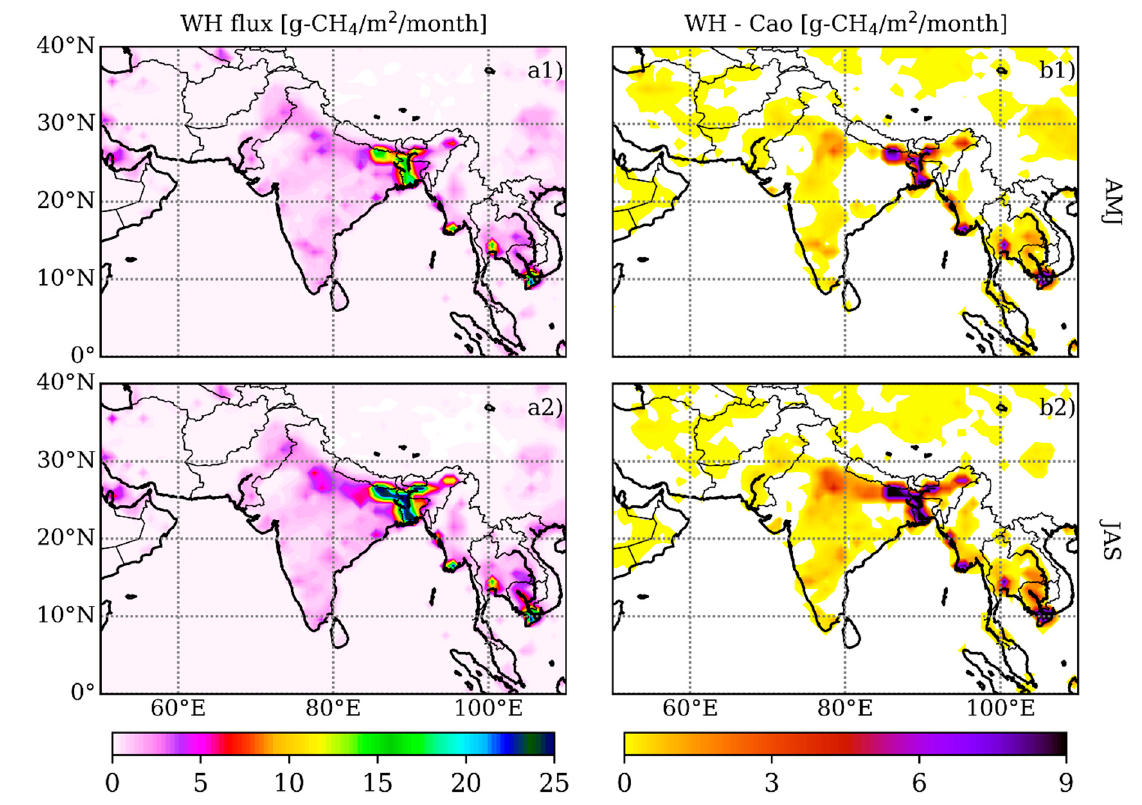
Figure 2. The surface CH 4 fluxes (g-CH 4 /m 2 /month) used for MIROC4-ACTM simulation: ( a1 , a2 ) from Cao scheme, ( b1 , b2 ) difference between schemes (WH—Cao). Panels ( a1 , b1 ), and ( a2 , b2 ) are for AMJ and JAS, respectively.